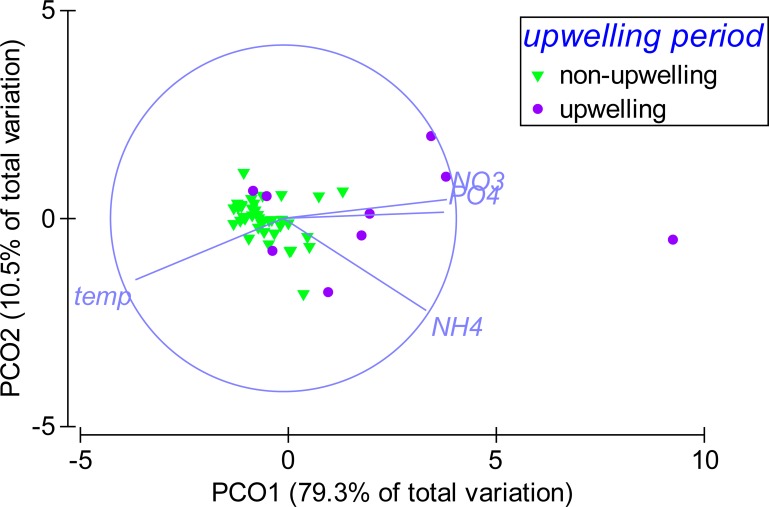
Temporal pattern in environmental parameters.Weekly sampling data from April 2013 to April 2014 were grouped by the factor upwelling period. The distance between data points reflects their similarity in environmental conditions (close = similar) and the separation along axes can be assigned to changes in environmental parameters (arrows). Sampling points in upwelling season are separated from the rest along PCO1, correlating highly with temperature (r = − 0.86), phosphate (PO4) (r = 0.93), ammonia (NH4) (r = 0.83) and nitrate (NO3) (r = 0.95).